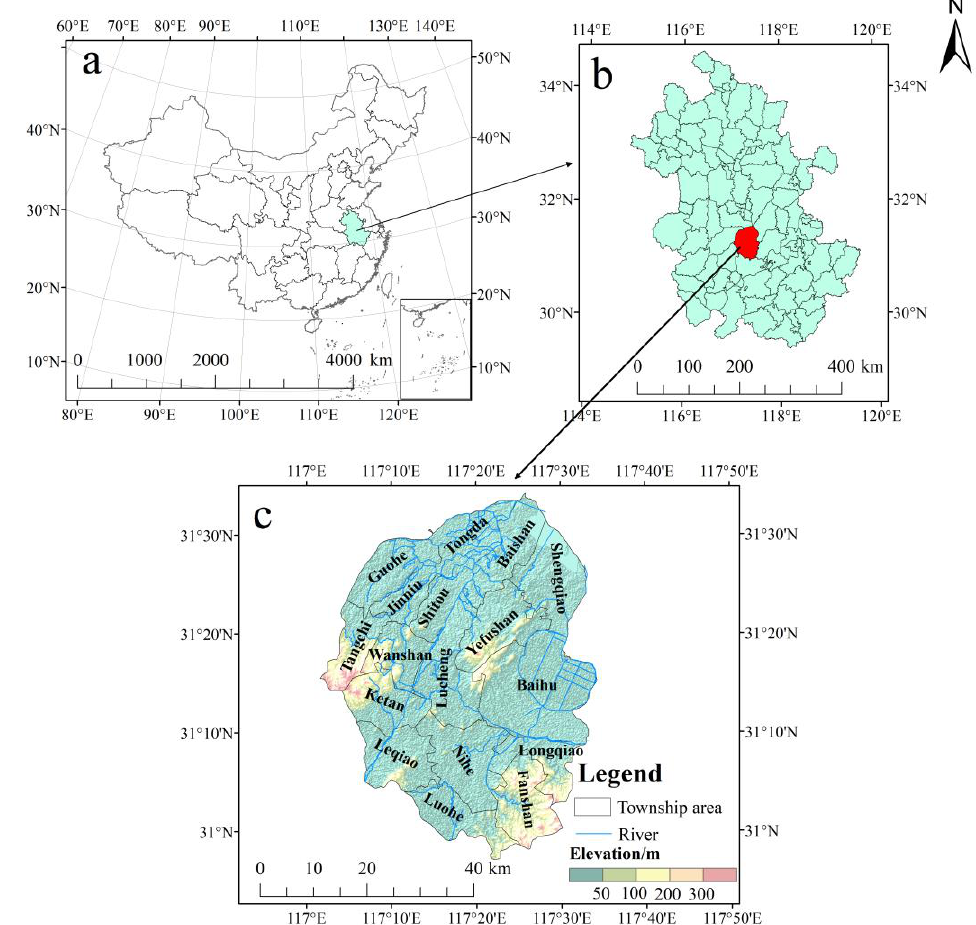
Figure 1. Location of the study area: Lujiang County ( c ) in Anhui province ( b ), China ( a ).